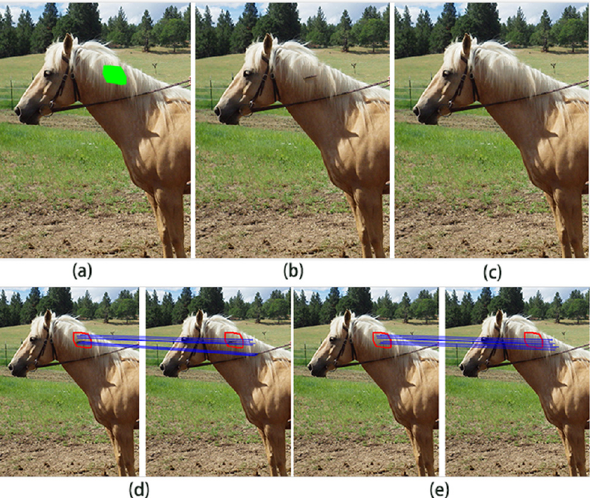
Fig 1. Gradient features for image completion: (a) input image, (b) result of Barnes et al [12], (c) result of our method, (d) approximate nearest neighbors without gradient features, (e) approximate nearest neighbors with gradient